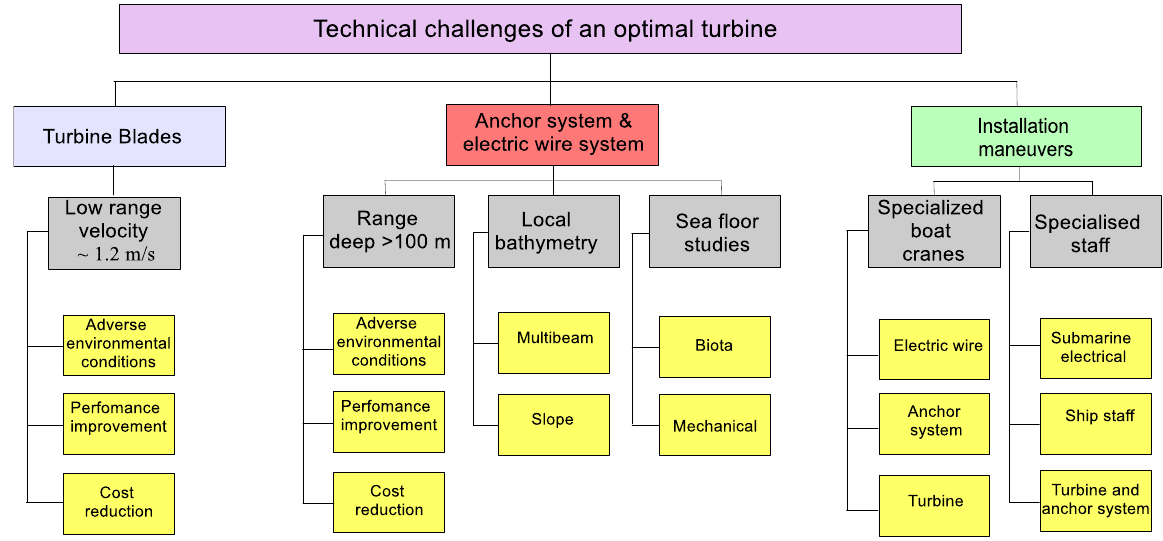
Figure 8. Diversity of technical challenges to be solved in order to have a suitable technology for the conditions of the Yucatan Current.